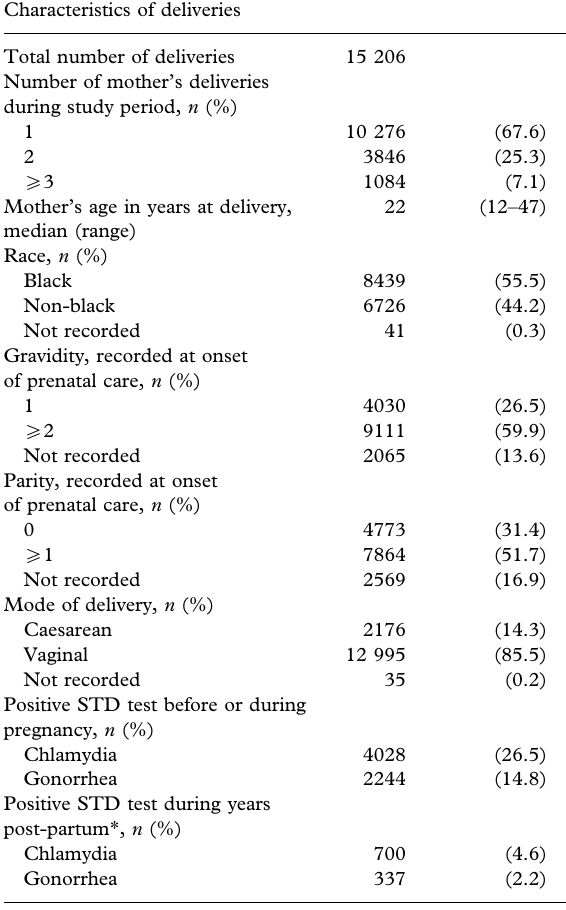
Table I. Characteristics of deliveries of infants at gestational age 37 to 44 weeks with a 5-minute Apgar score of 5 8 from January 1, 1992 through December 31, 1999 at Wishard Memorial Hospital, Indianapolis, IN. Characteristics of